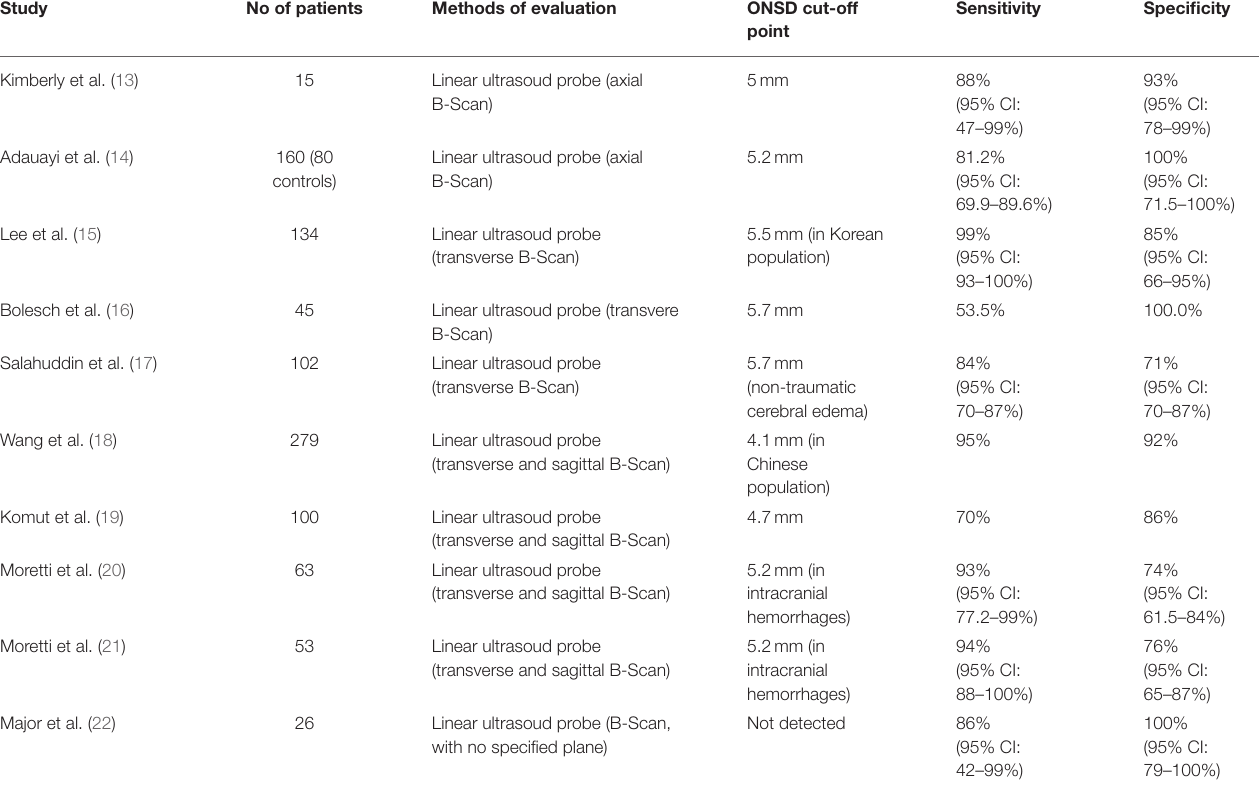
TABLE 1 | Potential cut-off to predict raised intracranial